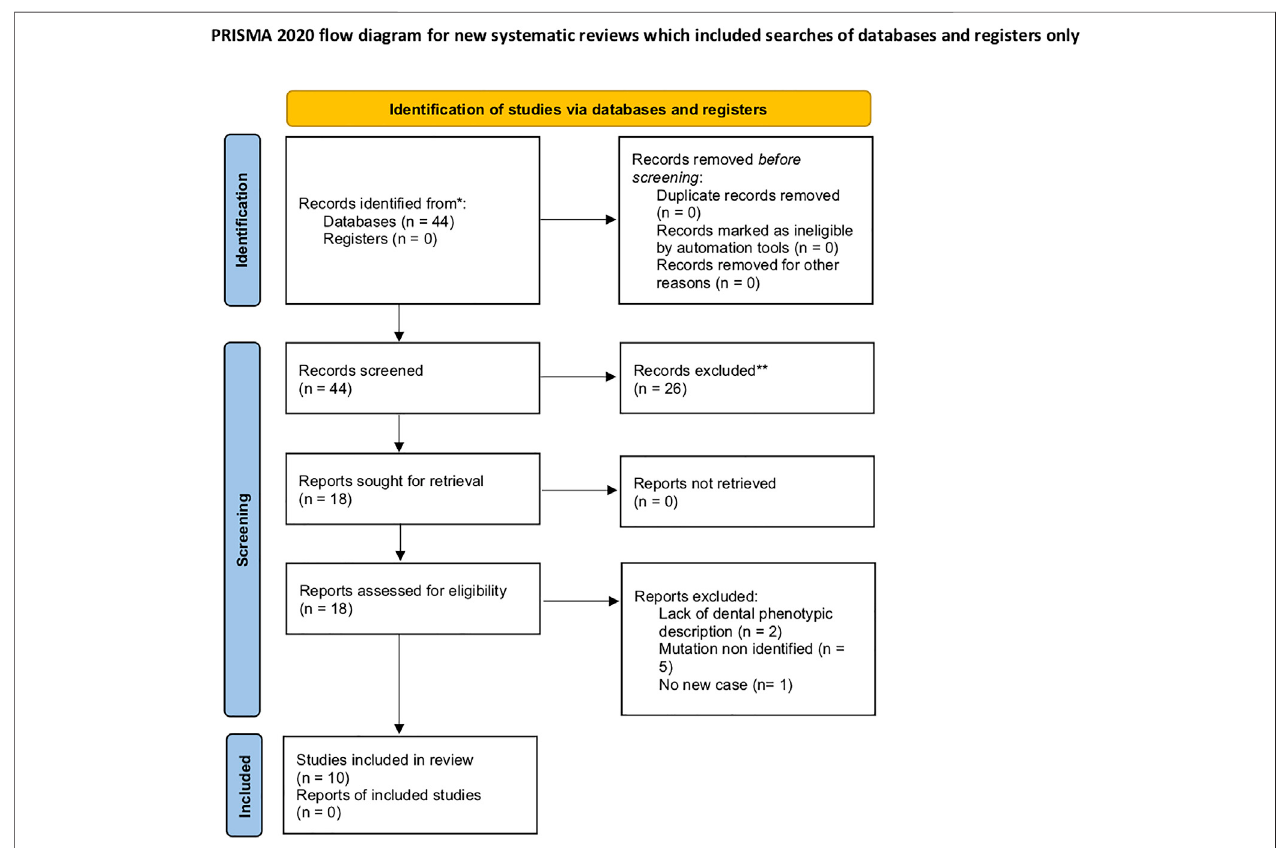
FIGURE 1 | Flow chart of